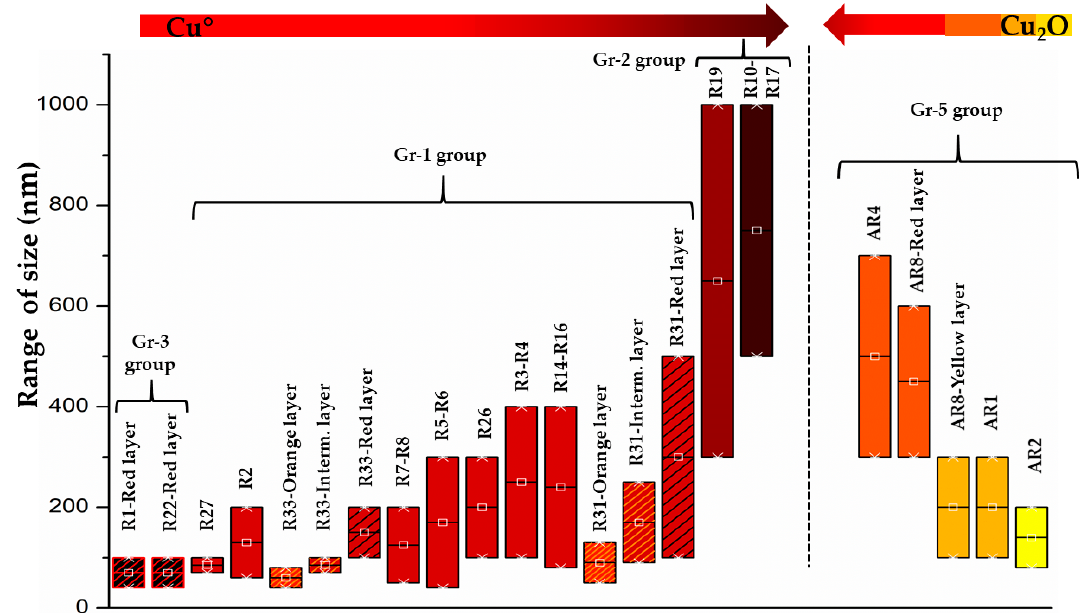
Figure 25. The colour changes with the increase of the colouring agent dimensions (Cu° on the right; Cu 2 O on the left).